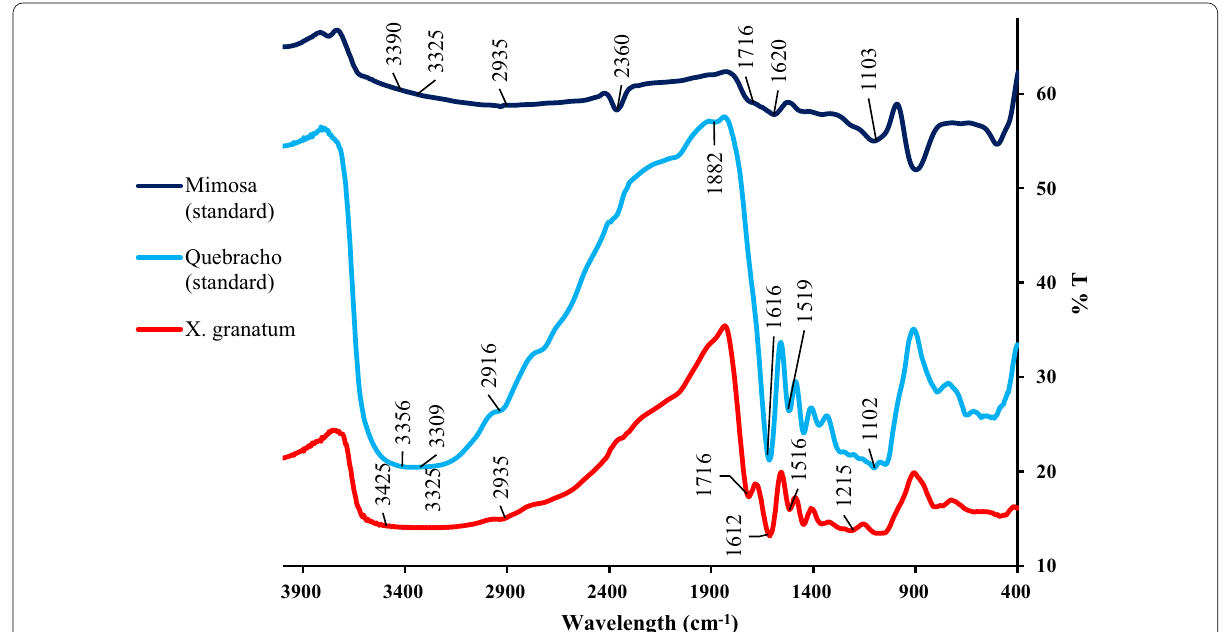
Fig. 4 FTIR spectra of standard mimosa, quebracho, and Xylocarpus granatum